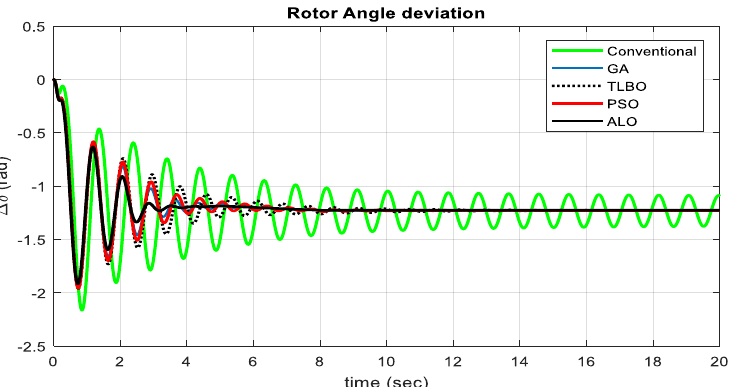
Figure 11. Rotor angle deviation of different algorithms with conventional fixed gain .